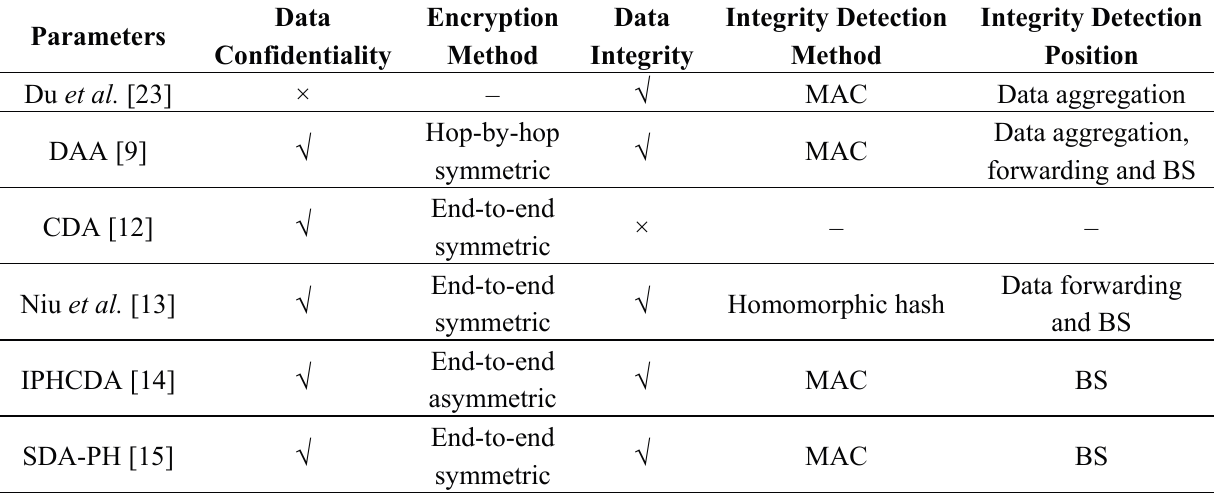
Table 1. The comparison of secure data aggregation protocols with respect to WSNs security